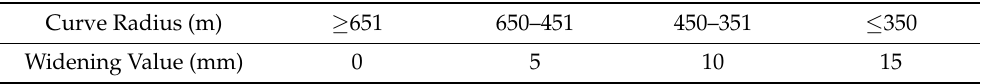
Table 9. Gage widening values in Chinese railways (1954) (mm).